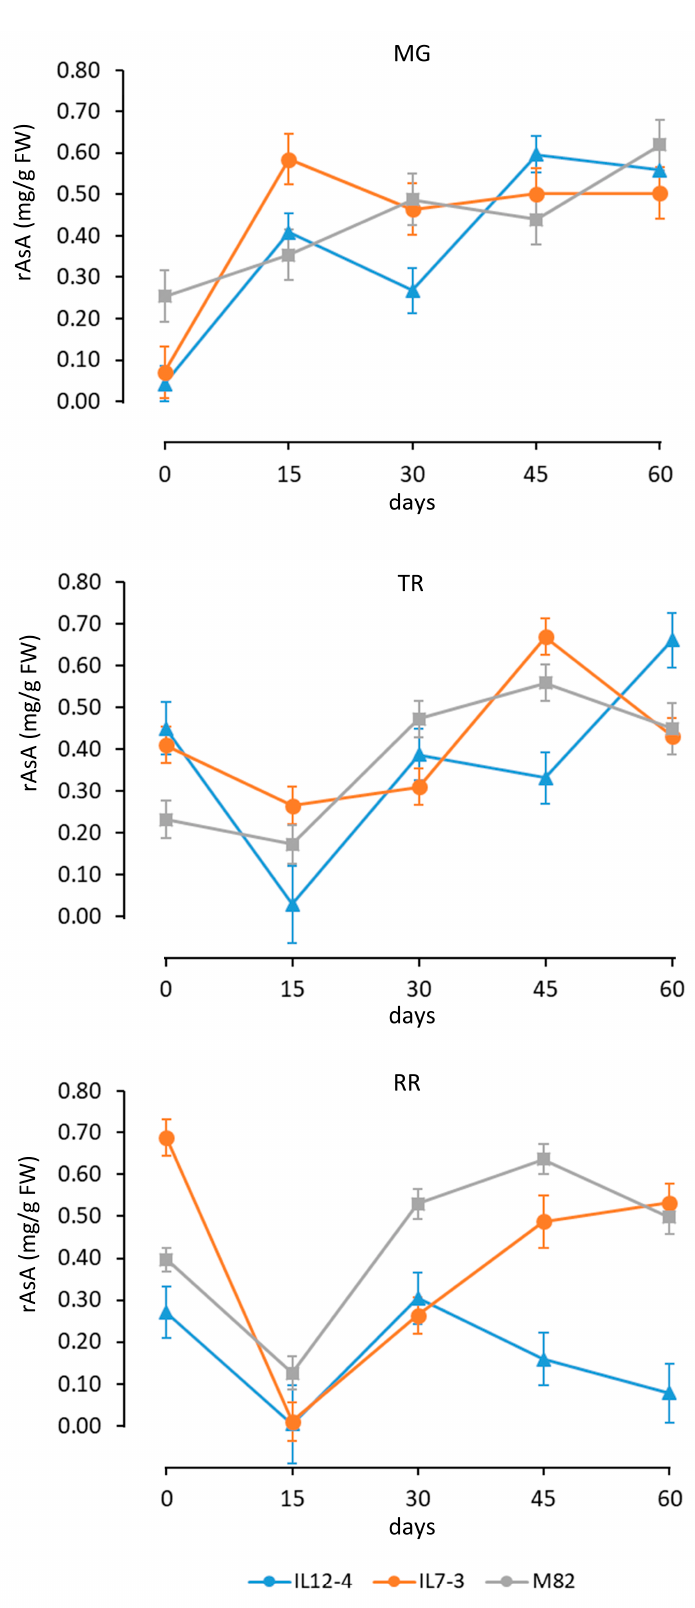
Figure 5. Dynamics of the reduced ascorbic acid (rAsA) in calli deriving from explant of fruits at the mature green (MG), turning (TR), and red ripe (RR) stage. For each source of explants, the graph reports the mean and standard deviation in the different genotypes from 0 to 60 days of tissue culture.